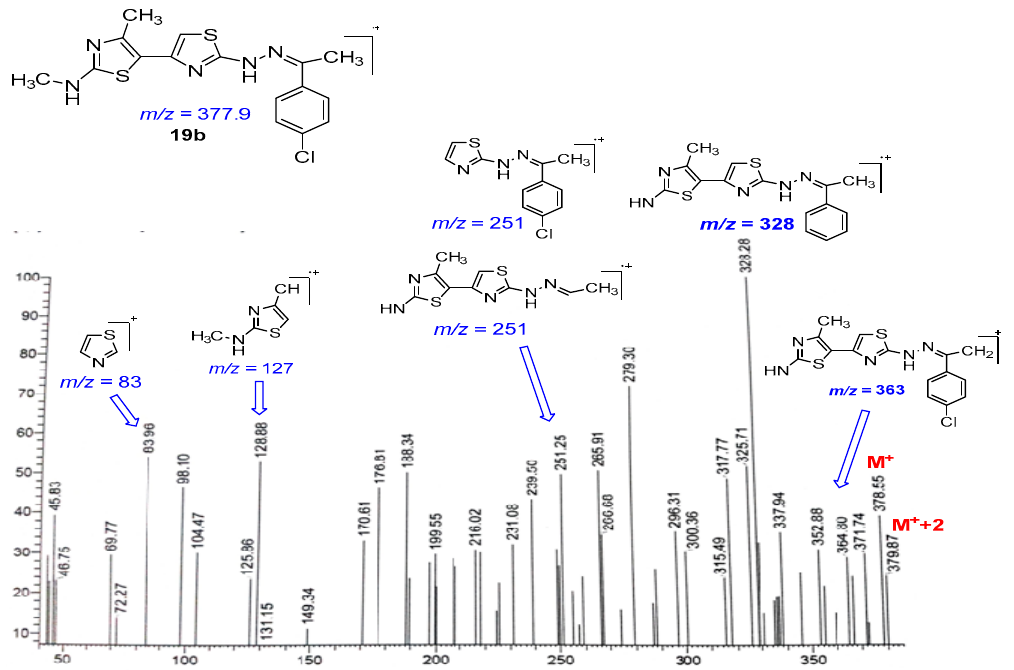
Figure 3. Mass fragmentations for compound 19b .